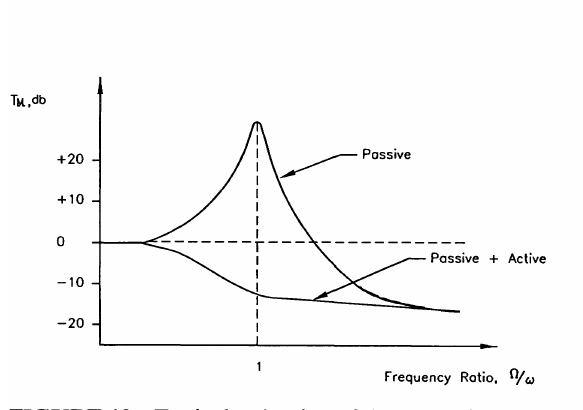
FIGURE 12 Typical reduction of the transmissibility of a passive system by the addition of an active sys